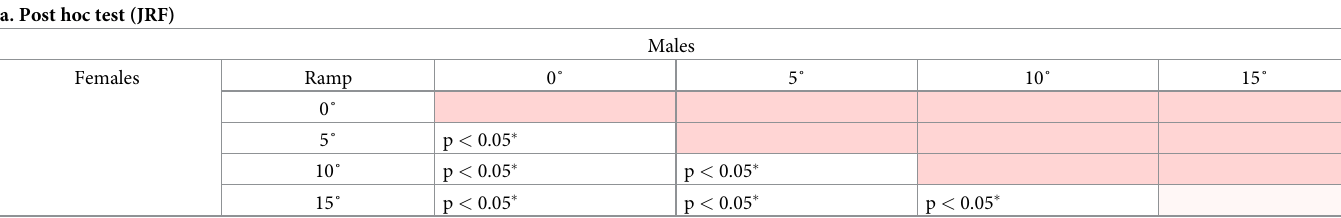
Table 3. The table demonstrates the post hoc test carried out on male and female subject’s categories. The test is based on the hip joint reaction force calculated for different ramp elevations as in Table 2. a. Post hoc test